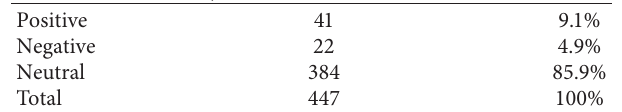
Table 5: Adjective collocations for